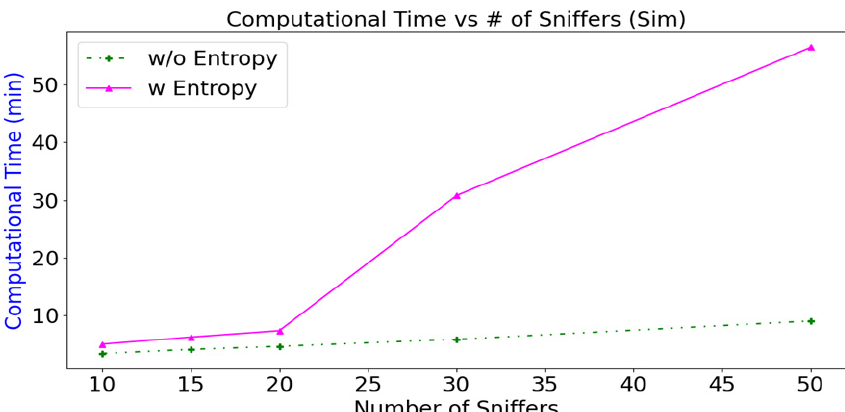
Figure 13. Calculation time versus number of Sniffers for different configurations of simulated data (10, 15, 20, 30, 50 Sniffers).